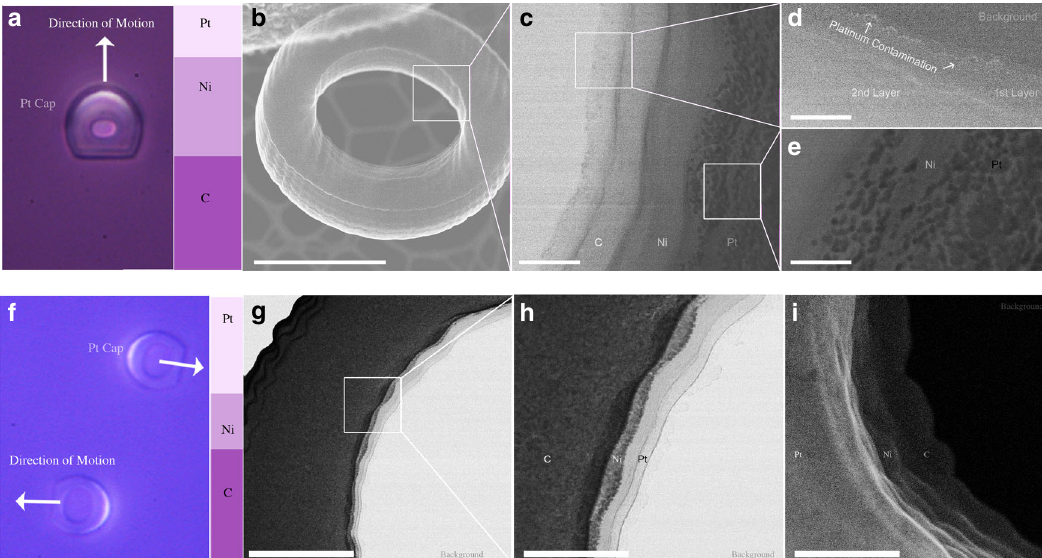
Fig. 4 High-resolution scanning transmission electron microscopy (STEM) micrographs. a An image of the swimming orientation for tori with 40 nm nickel and 10 nm platinum. The Janus glazed tori rest with their polymer structure near the substrate, and the patchy tori swim platinum-leading face forward. b A secondary-electron STEM image focused on the cross section of a single layer in the 3D printed structure. The scale bar is 3.25 μ m. c A secondary- electron STEM image of the different materials deposited on separate layers of the tori. The nickel forms a smooth structure while the platinum nucleates into droplets on the binding layer. The scale bar is 300 nm. d A bright- fi eld image of platinum contamination (in white) on the fi rst polymer layer in the tori. The platinum contamination is responsible for an enhanced conductivity on the surface of the polymer. The scale bar is 200 nm. e A dark- fi eld image of the platinum droplets on the uniform nickel binding layer. The platinum formed droplets (cid:1) 20 nm in diameter. The scale bar is 100 nm. f An image of the swimming orientation for tori with 10 nm nickel and 40 nm platinum. The Janus tori rest with their metal cap near the substrate, and the patchy tori swim polymer-leading. g Cross-sectioned, dark- fi eld image of a tori coated in 10 in nickel and 40 nm platinum. We see a clear separation between the carbon polymer, nickel binding layer, and catalytic platinum layer. The scale bar is 700 nm. h A close-up, dark- fi eld image at the interfaces between platinum and and nickel. We observe a smooth platinum layer ~200 nm thick. i Secondary-electron imaging (on STEM) of the smooth platinum layer. The platinum layer covered almost entirely the nickel binding layer. The scale bar is 200